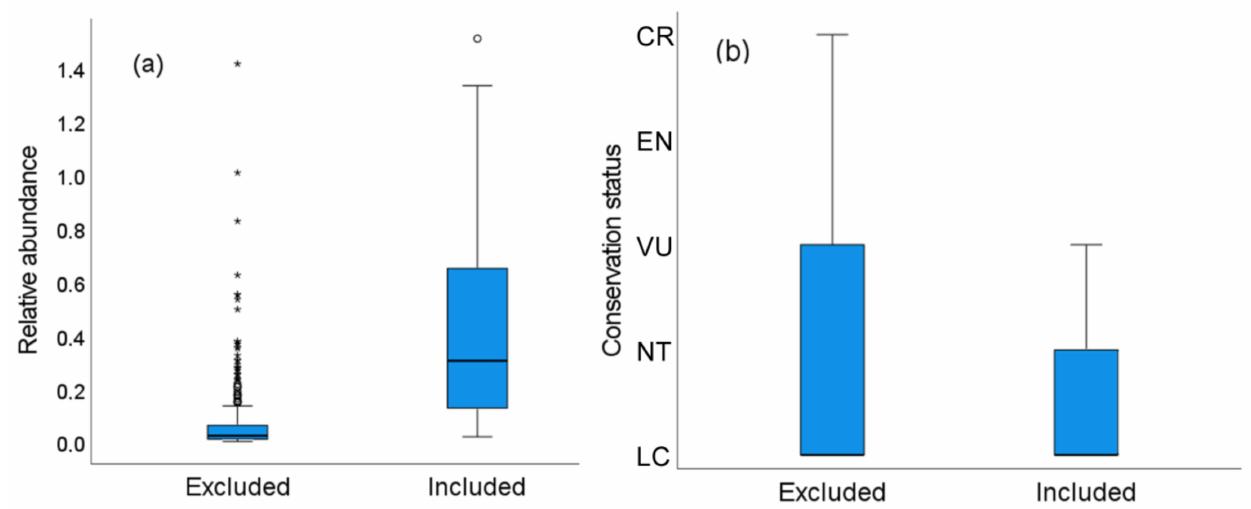
Figure 5. Several study cases and species were excluded from DS modeling because they did not met the minimum number of visual contacts to allow for estimating probabilities of detection and densities. ( a ) Study cases excluded (64% of 575) corresponded to species with lower relative abundances; ( b ) Species excluded (47% of 137) showed a poorer